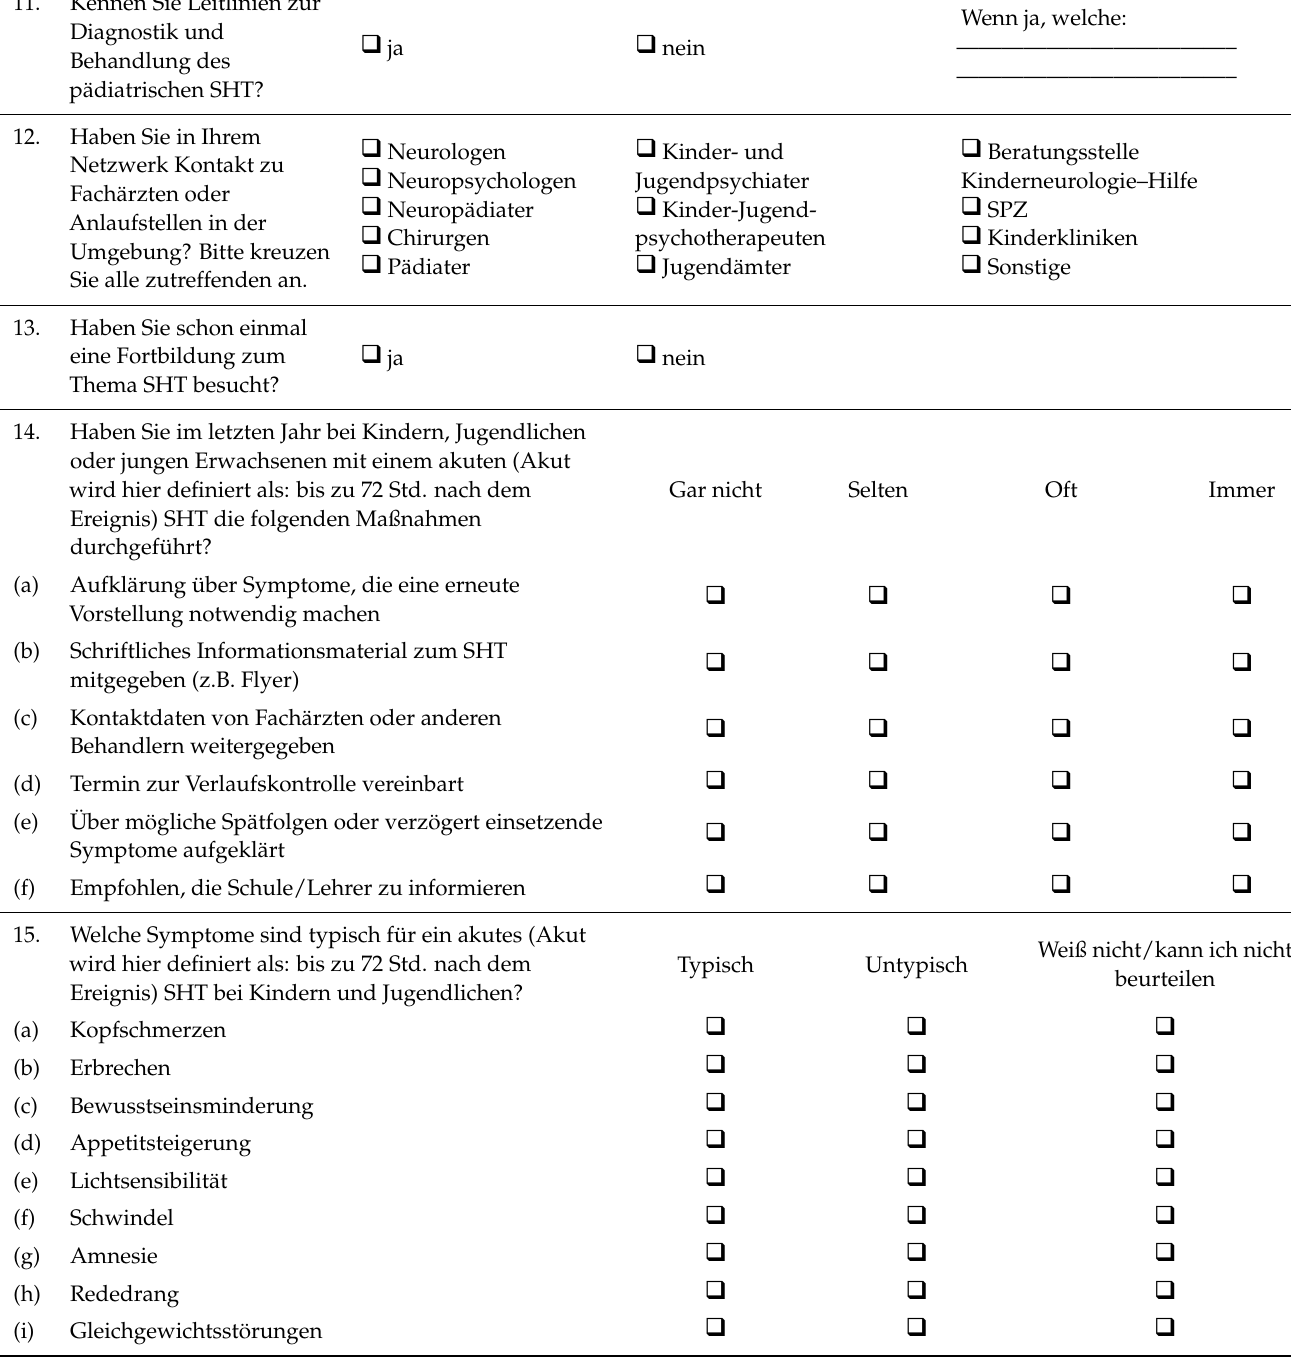
einsetzende Symptome